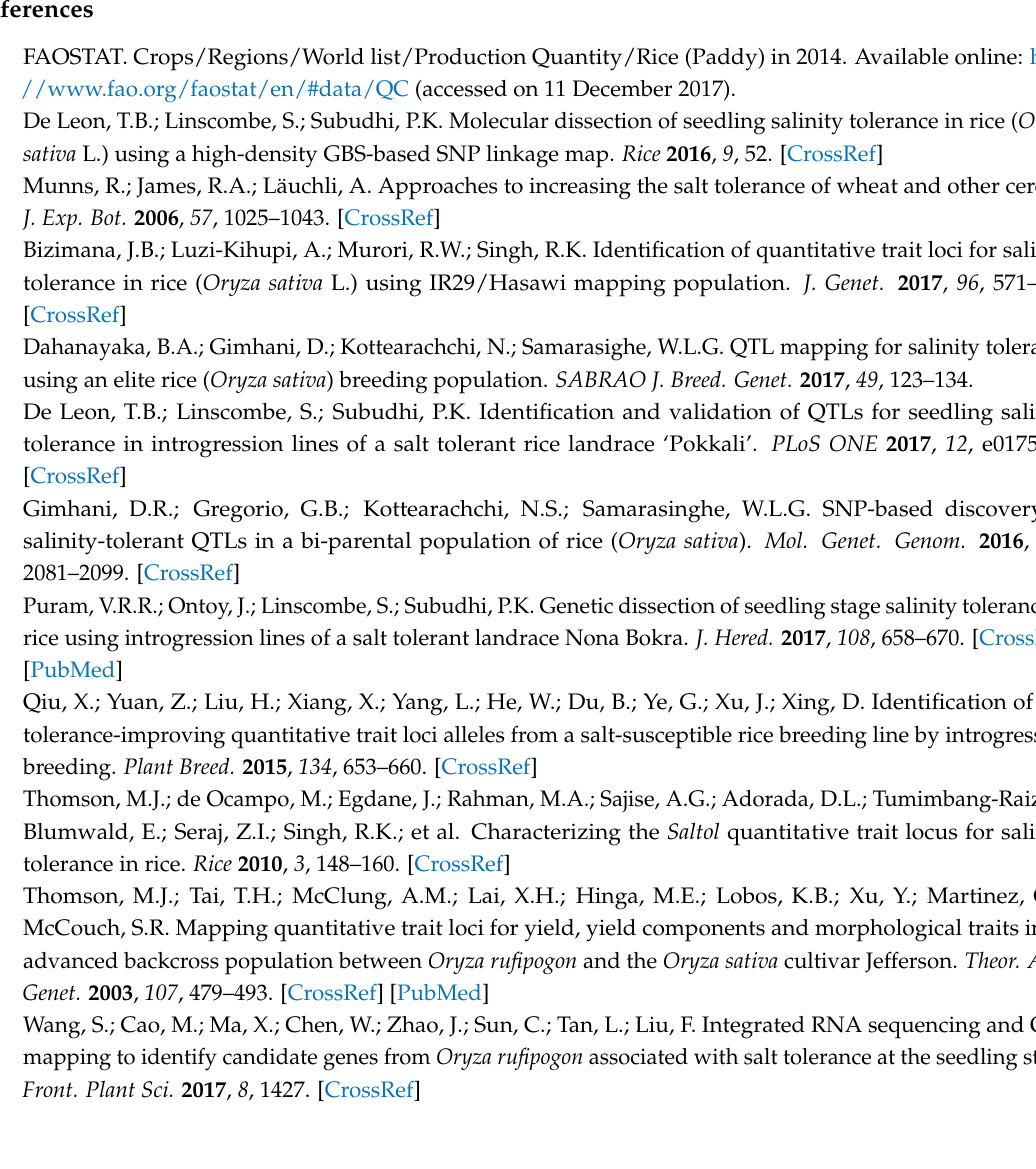
chromosome; Figure S2: Physical location of markers (red color) linked to the meta-QTLs listed in Table S4 and nearby candidate genes within the identified meta-QTL regions. The physical positions were shown as MB in left side of the chromosome bar; Figure S3: Seedling screening for SIS, SNC, SKC and SNK of rice genotypes in hydroponic experiment. A. Control, B. Replication 1, and C. Replication 2; Table S1: High density reference map based on the mapping information of SSR [50] and SNP markers [2,7]; Table S2: Integrated consensus map; Table S3: List of rice germplasm and breeding lines used for meta-QTL validation; Table S4: Details of SSR markers used for meta-QTL validation; Table S5: Summary of the integrated consensus map; Table S6: List of genes identified in the six meta-QTL regions; Table S7: Gene ontology enrichment analyses of the meta-QTLs regions related to seedling stage salt tolerance traits; Table S8: List of significant GO terms obtained in the five meta-QTL regions for seedling stage salt tolerance; Table S9: A summary of genotyping results in rice germplasm and breeding lines using all linked SSR markers associated with meta-QTLs identified in this